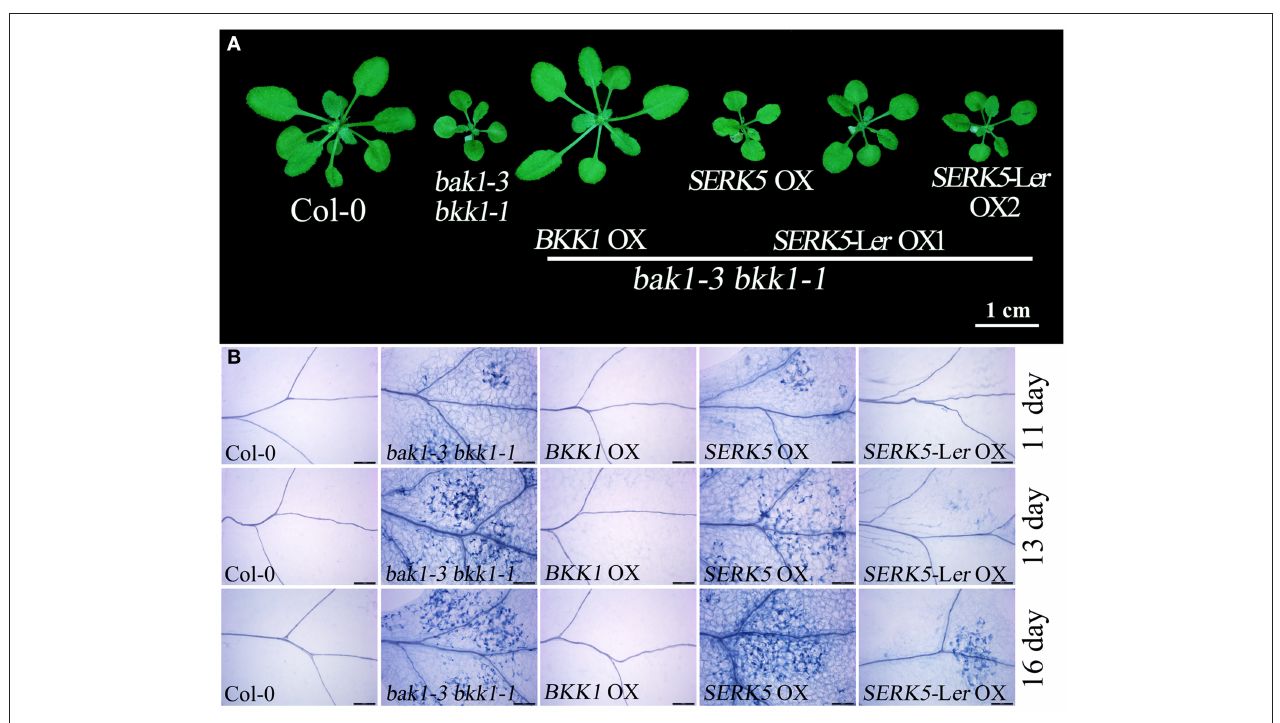
FIGURE 10 | Overexpression of SERK5 -L er can delay the cell death in bak1-3 bkk1-1 . (A) The aerial phenotype of 25-day-old seedlings. (B) The cell death was indicated by trypan-blue staining in the cotyledons of 11, 13, and 16-day-old seedlings grown at 22 ◦ C under long-day conditions (16h light/8h dark). Scale bars = 200 µ